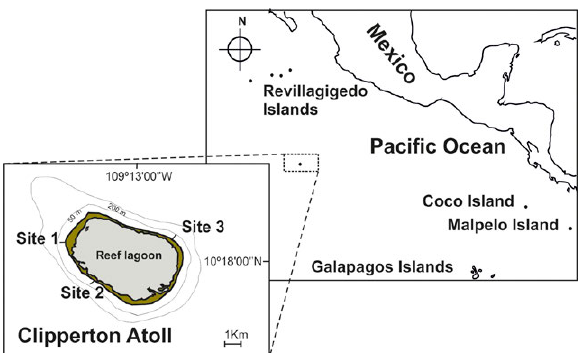
Fig. 1. – Location of study area and sampling sites at the Clipperton